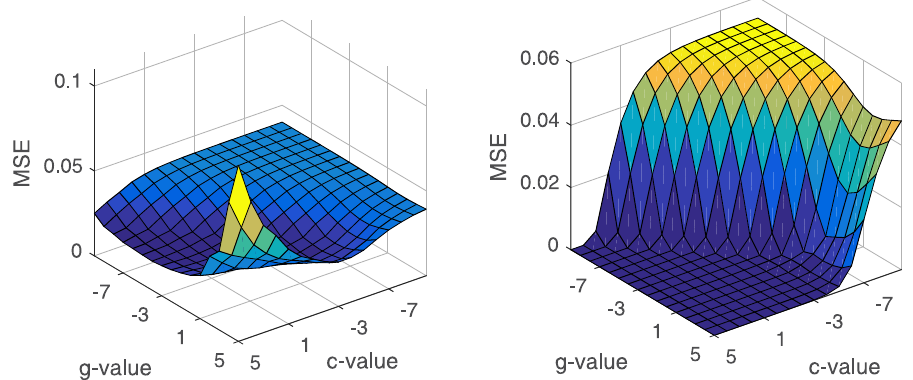
Fig 4. The results of grid search for C and g in SVM model. The left part is the result of SVM model for monthly incidence prediction. And the right part is the result of SVM model for monthly cases number prediction.